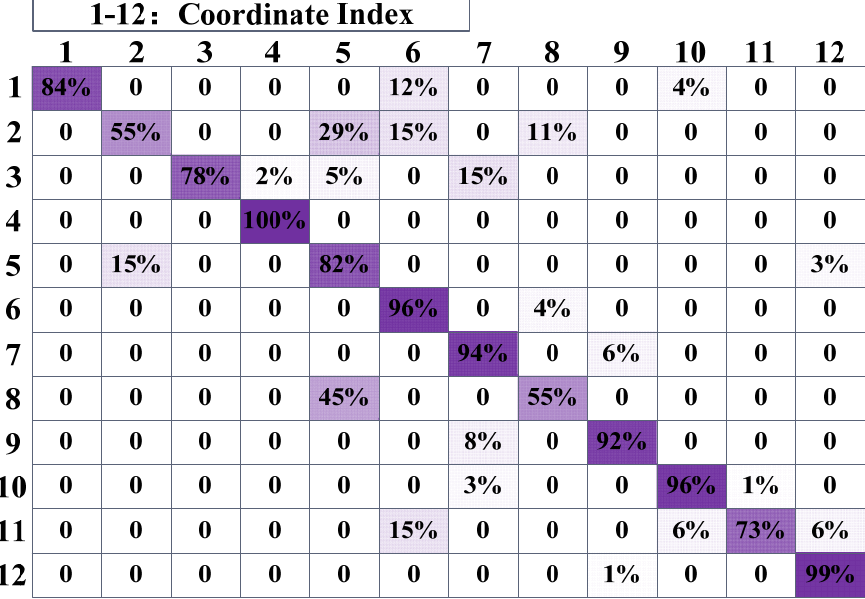
Figure 13. The statistics of the localization accuracy when the target passes through different coordinate points in drawing room 2.